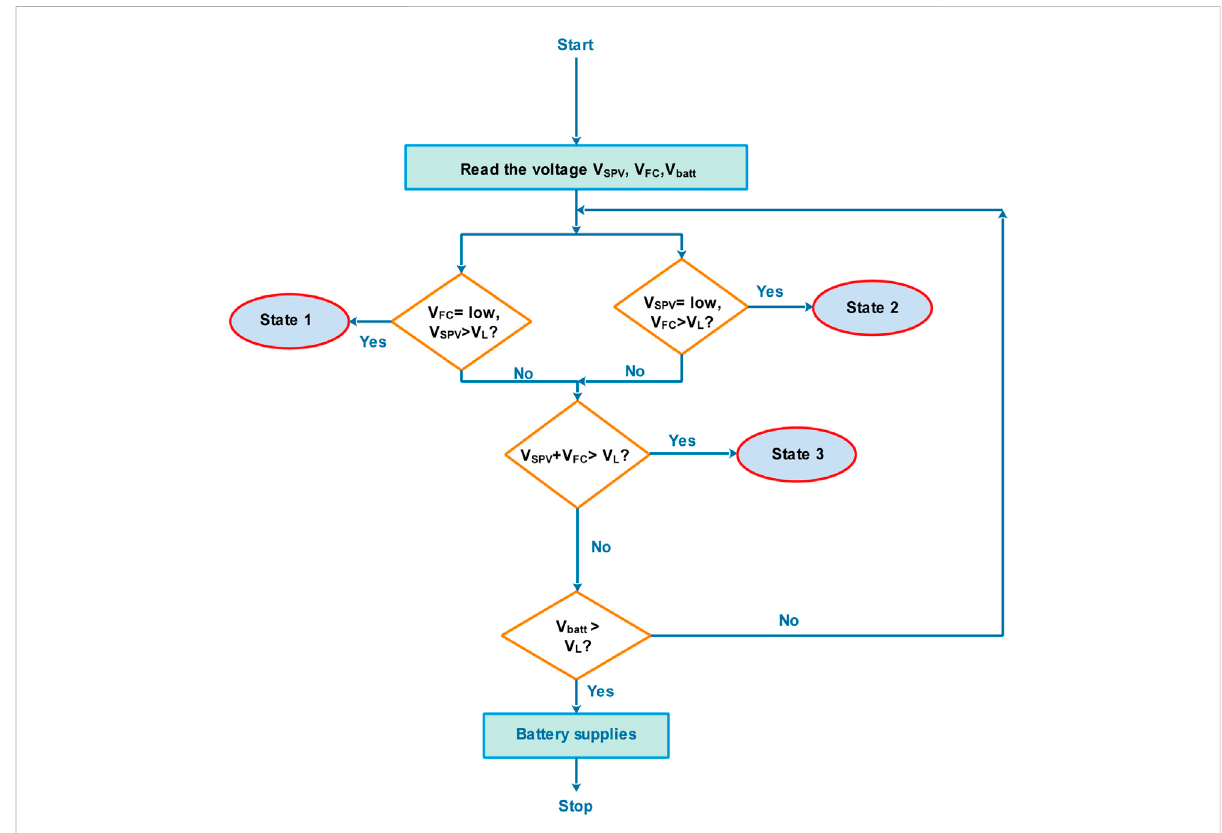
FIGURE 5 Flowchart for the control technique.